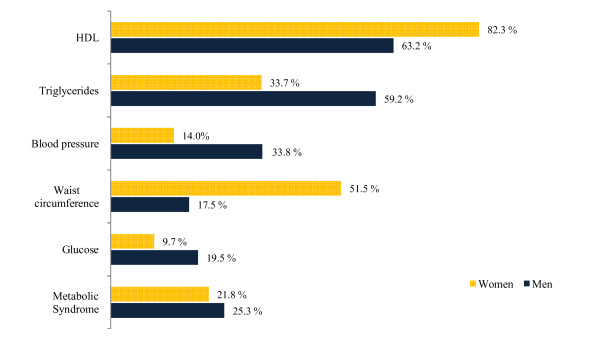
Prevalence of metabolic syndrome and its components by sex (n = 5118). Probability of chi-squared test: p < 0.000 in all cases.